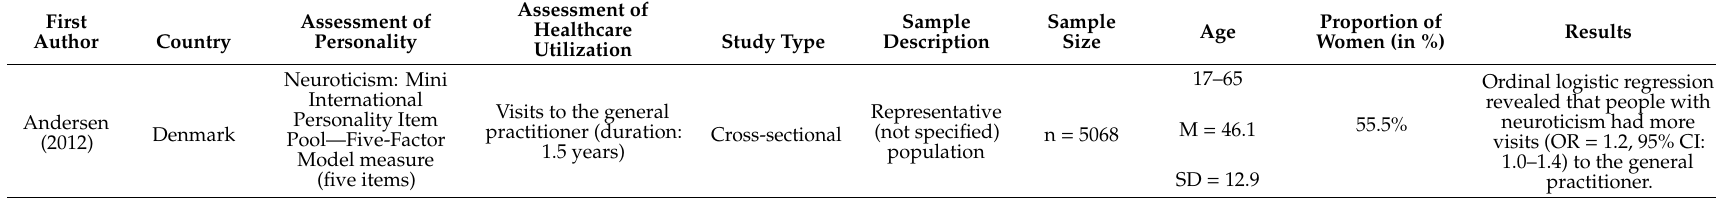
Table 2. Study overview and main